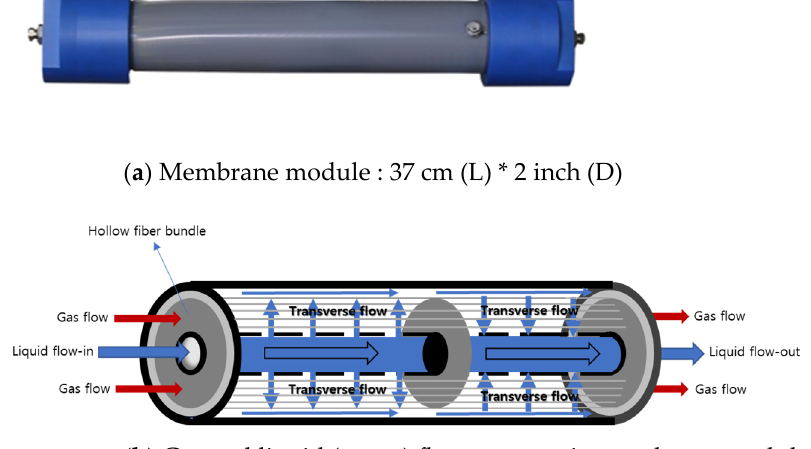
Figure 5. Membrane module used in this study and the schematical representation of membrane module structure and the gas and liquid (water) flows in the membrane module: ( a ) membrane module used in this study and ( b ) gas (lumen side) and liquid flow (shell side) flows in module and module structure.